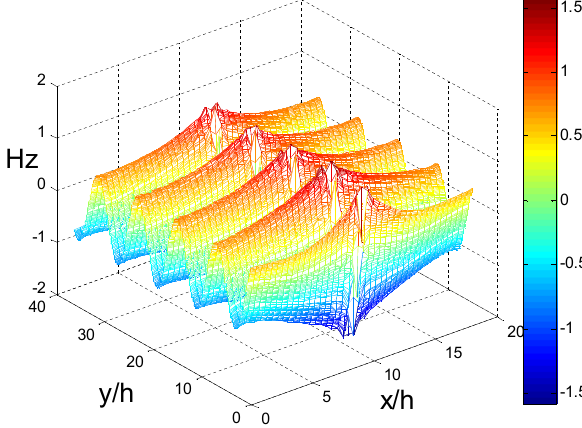
Figure 5. Near field propagation distribution representing the wavelength of 496 nm.